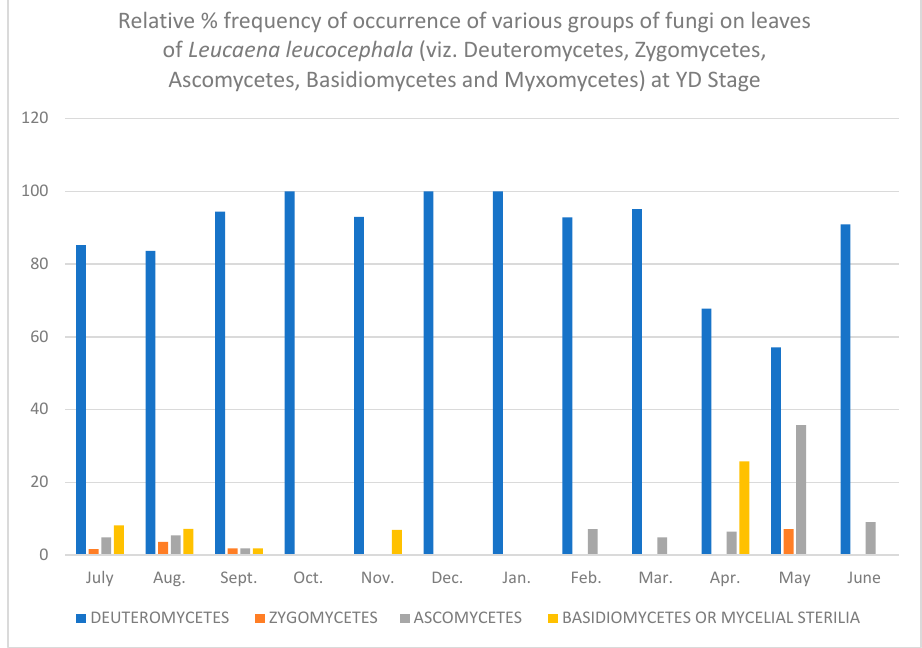
Figure 3. Relative % frequency of occurrence of various groups of fungi on leaves of Leucaena leucocephala (viz. Deuteromycetes, Zygomycetes, Ascomycetes, Basidiomycetes and Myxomycetes) at YD Stage. Table 4. Percentage frequency of occurrence of various fungi on yellow-Fallen leaves (YF).